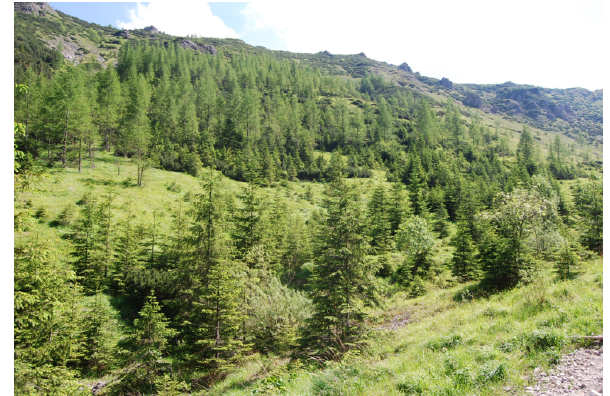
Figure 3. Present-day view of Jaworzynka